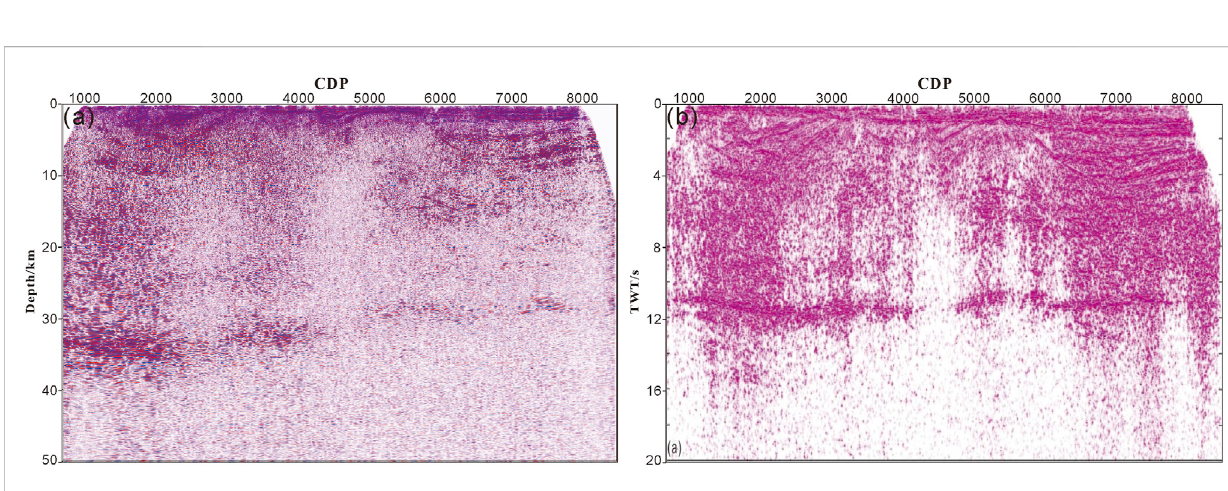
FIGURE 11 The comparison of the PSDM pro fi le and stack pro fi le. (A) PSDM pro fi le (B) Stack pro fi le of the same survey line (Li et al.,